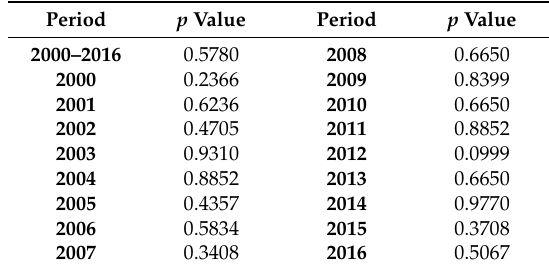
Table 15. Wilcoxon Test results ( p values)—P/B indexes.